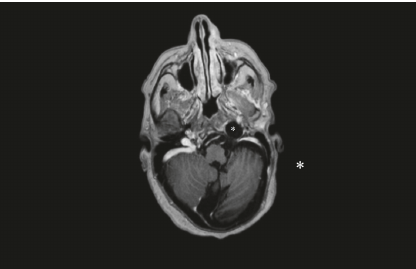
Figure 3: Axial T2 weighted image shows CSF and meninges herniated to the left jugular foramen (∗) .